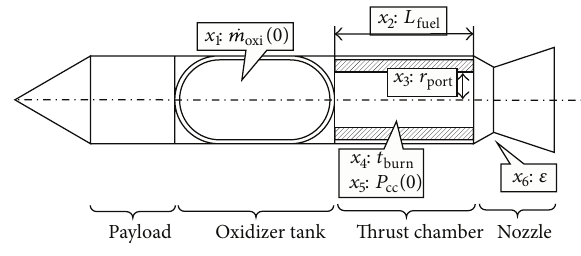
Figure 11: Schematic of the hybrid